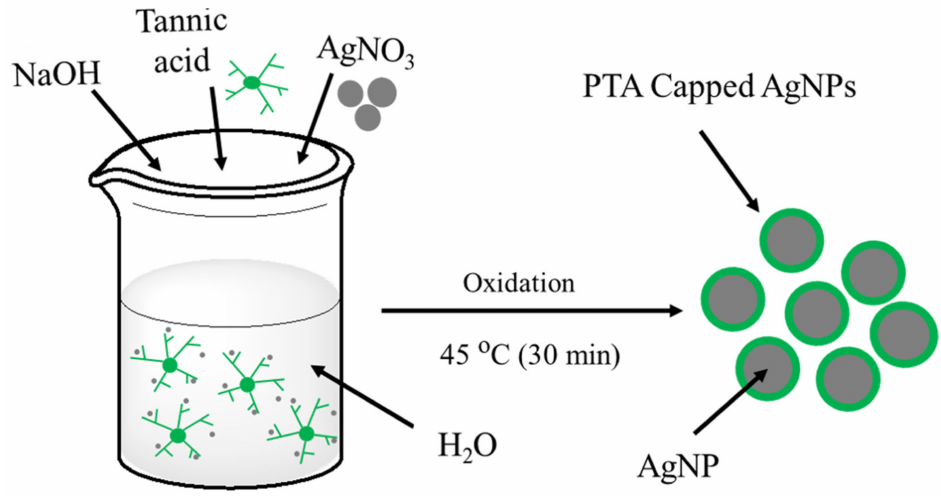
Figure 1. The schematic diagram for the green synthesis of Ag NPs-PTA. Bare Ag NPs were synthesized from AgNO 3 (1 mM) salt, using sodium borohydride (NaBH 4 , 1 mM) as a reducing agent and trisodium citrate (3.6 mM) as a secondary reducing as well as capping agent. The fresh solutions of all the chemicals were prepared. The homogeneous mixture of NaBH 4 and trisodium citrate was stirred at 500 RPM and the temperature of the solution was increased to 60 ◦ C under darkness. After 30 min of vigorous stirring, the required volume of the AgNO 3 was added dropwise into the reaction mixture. The pH of the reaction mixture was adjusted to 10.5 using NaOH (1 M) and the temperature was increased to 90 ◦ C. The reaction conditions were maintained for 20 min until the synthesis of bare Ag NPs. The mixture was cooled down and the synthesized bare Ag NPs were washed with DI water using a centrifuge (1100 RPM for 15 min). Obtained Ag NPs were washed thrice to completely remove the unreacted